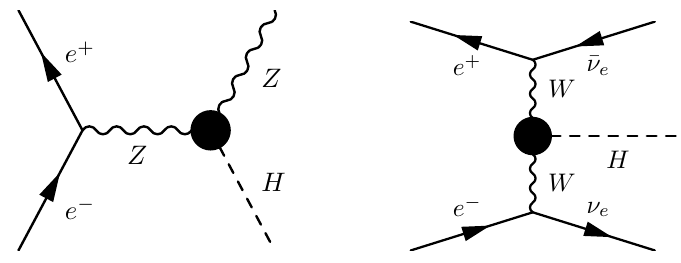
Figure 1 . Feynman diagrams for single Higgs production. The black blob corresponds to the one-loop HV V form